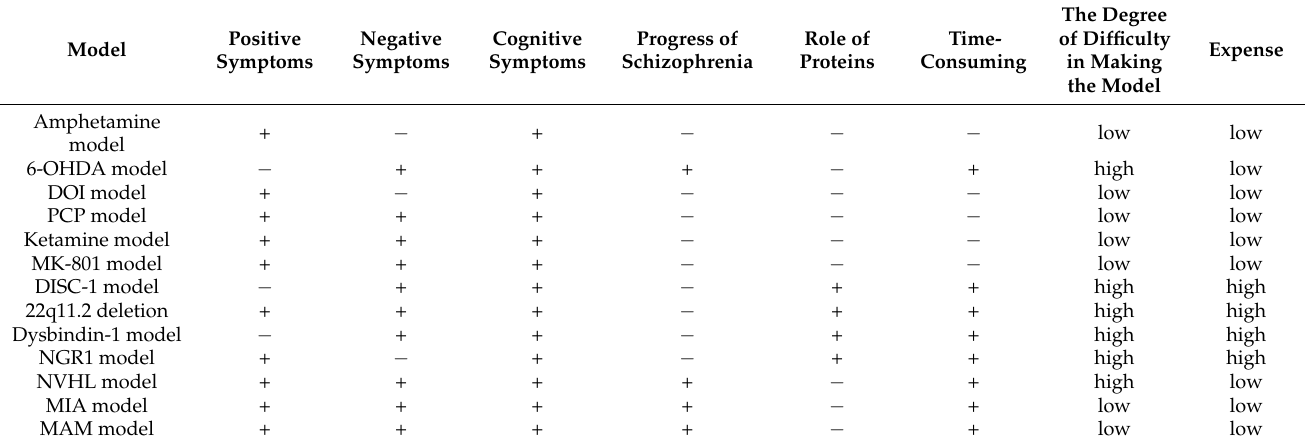
Table 4. Comparison of animal models of